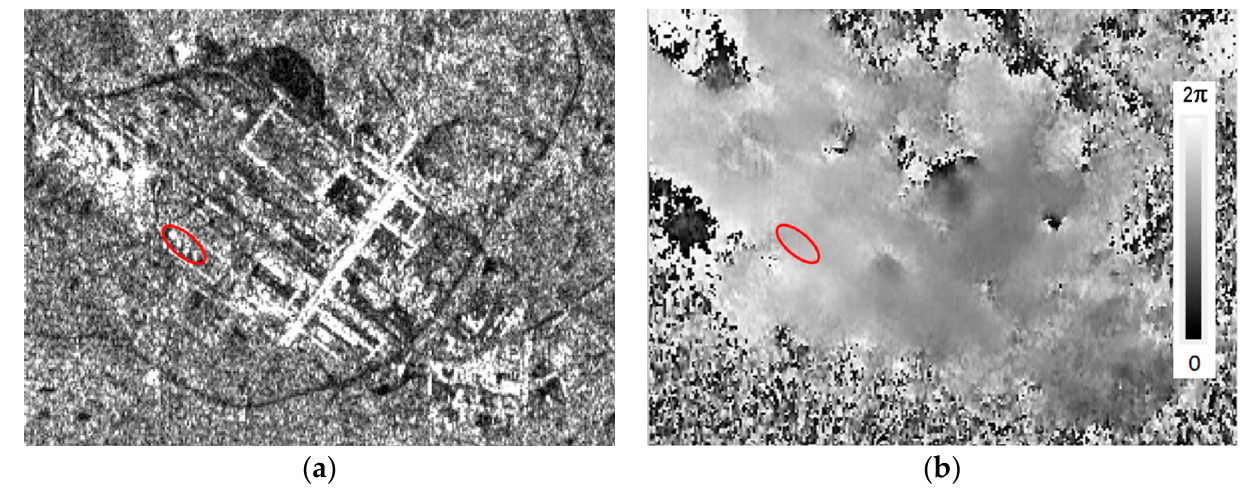
Figure 7. Sentinel-1 SAR images of the Kolesnikov metallurgical plant and thermal power plant territory with encircled fuel tank’s location: ( a ) Amplitude image; ( b ) Interferogram covering the catastrophic event.